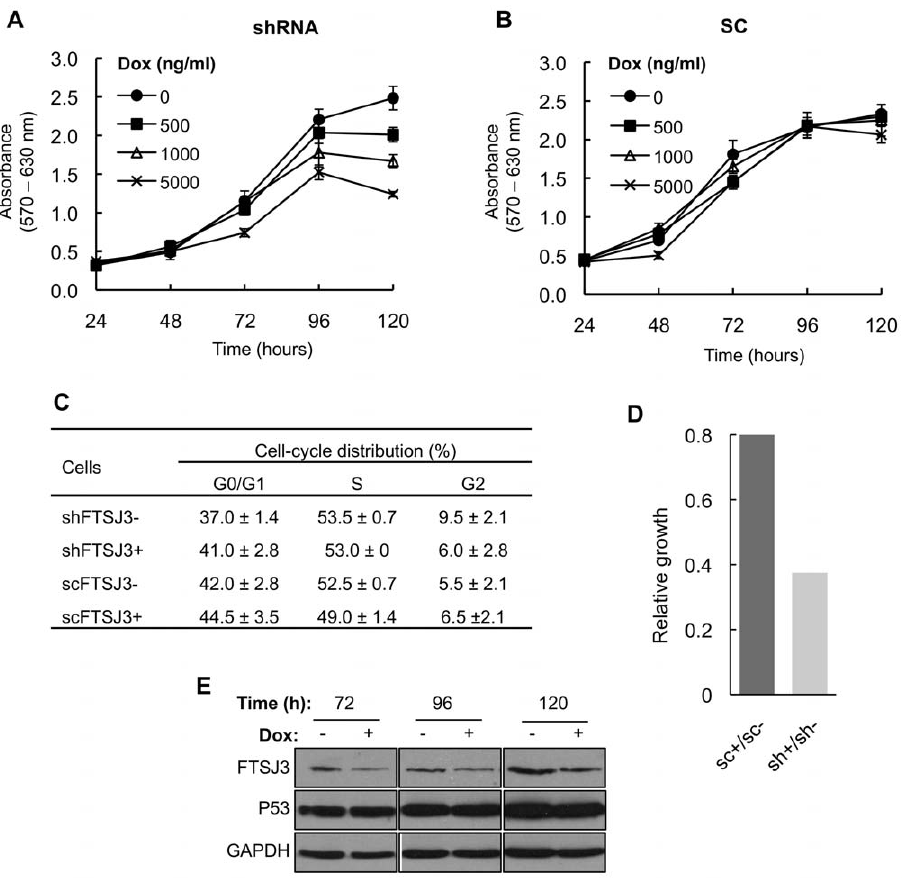
Figure 8. Analysis of cell proliferation over a 5-day period of induction with doxycycline (Dox). ( A ) Proliferation rate of cells expressing the shRNA targeting FTSJ3. ( B ) Proliferation rate of cells expressing the scrambled control SC RNA. (The graphs represent one of four independent assays performed using four technical replicates for each cell treatment). Induction of the shRNA targeting FTSJ3 leads to a reduction in cell proliferation. ( C ) Cell cycle analysis by fluorescence-activated cell sorting (FACS). FACS analyses were performed with HEK293 Flp-In T-Rex cells stably transfected with the pFRT-U6tetO plasmid expressing either a shRNA targeting FTSJ3 (shRNA) or a scrambled control (SC) and induced ( + ) or not ( 2 ) with 5 m g/ml of doxycycline for 5 days. ( D ) Relative growth rate differences between cells expressing the scrambled control scRNA (sc + /sc 2 ) and cell expressing the shRNA targeting the FTSJ3 mRNA (sh + /sh 2 ) induced ( + ) or not ( 2 ) with doxycycline for the 120 h time point. ( E ) Immunoblot analysis showing the levels of the FTSJ3 and p53 proteins in cells expressing either the shRNA targeting the FTSJ3 mRNA or the scrambled control induced ( + ) or not ( 2 ) with doxycycline. GAPDH was used as a gel loading control. The levels of FTSJ3 are reduced as expected and the levels of p53 are not